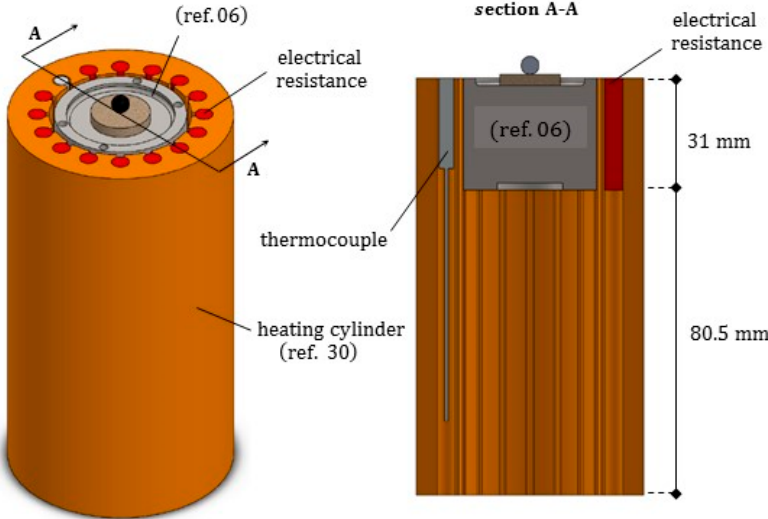
Figure 6. Axonometric view and longitudinal radial section of the heating ceramic element, including in its vertical grooves the electrical resistances (colored in red) and the thermocouple (in grey), and surrounding the sample holder.